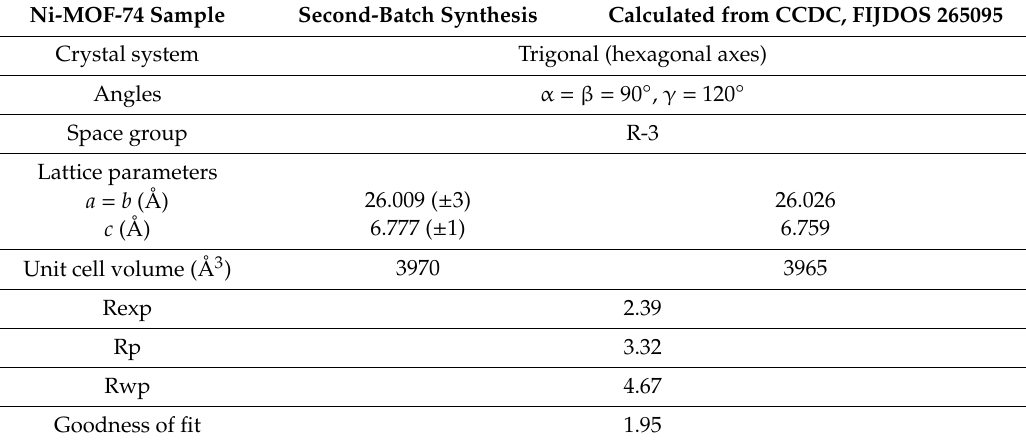
Table 2. Stages of optimization of washing processes in solvothermal synthesis.